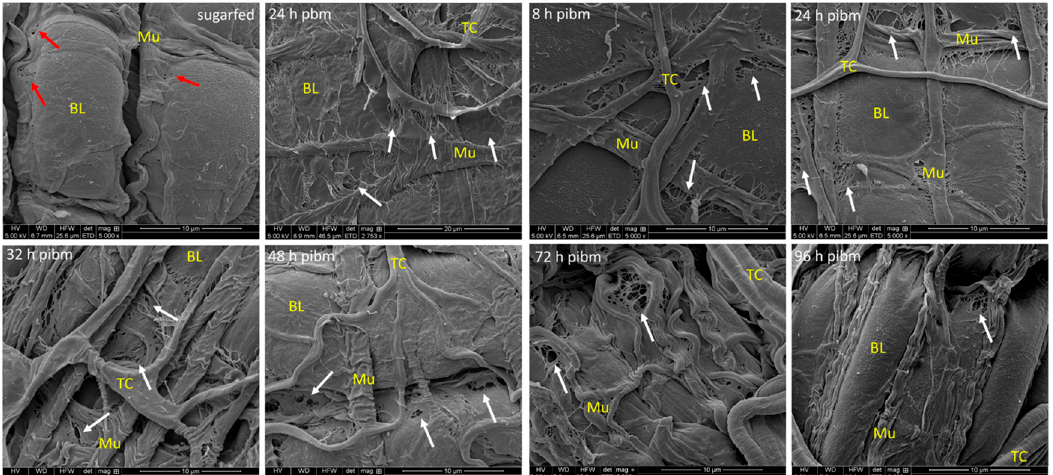
Figure 2. Ultrastructural (SEM) imaging of the midgut surface of sugarfed Ae. aegypti in comparison to mosquitoes that had ingested a non-infectious, artificial bloodmeal at 24 h post-bloodmeal (pbm) or a CHIKV containing, artificial bloodmeal (titer in the bloodmeal: 10 7 pfu/mL) at 8, 24, 32, 48, 72, and 96 h post-infectious bloodmeal (pibm). The midgut tissue of sugarfed females appears relaxed and deeply invaginated. Midgut-associated circular and longitudinal muscles are visible. Red arrows point to slight tissue damage occasionally visible, due to tearing of the basal lamina (BL). At 8 h pibm, the outer layer of the BL is torn and disrupted in close proximity to muscle tissue (exemplified by white arrows). Disruption of the outer over-stretched BL layer adjacent to muscle tissue is strongly apparent at 24 pbm/pibm and 32 h pibm. At 48 h pibm, the midgut BL is beginning to relax and contract, torn areas of the BL near to muscles become less prominent. This trend continues; at 72–96 h pibm, disrupted regions of the outer BL layer are still visible although less prominent. Images were generated using a FEI Quanta 600F scanning electron microscope. All images (except: 24 h pbm at 2753 × magnification) were captured at 5000 × magnification. BL = basal lamina; Mu = muscle; TC = tracheal cell. Additional (replicate) images are presented in Figure S1.